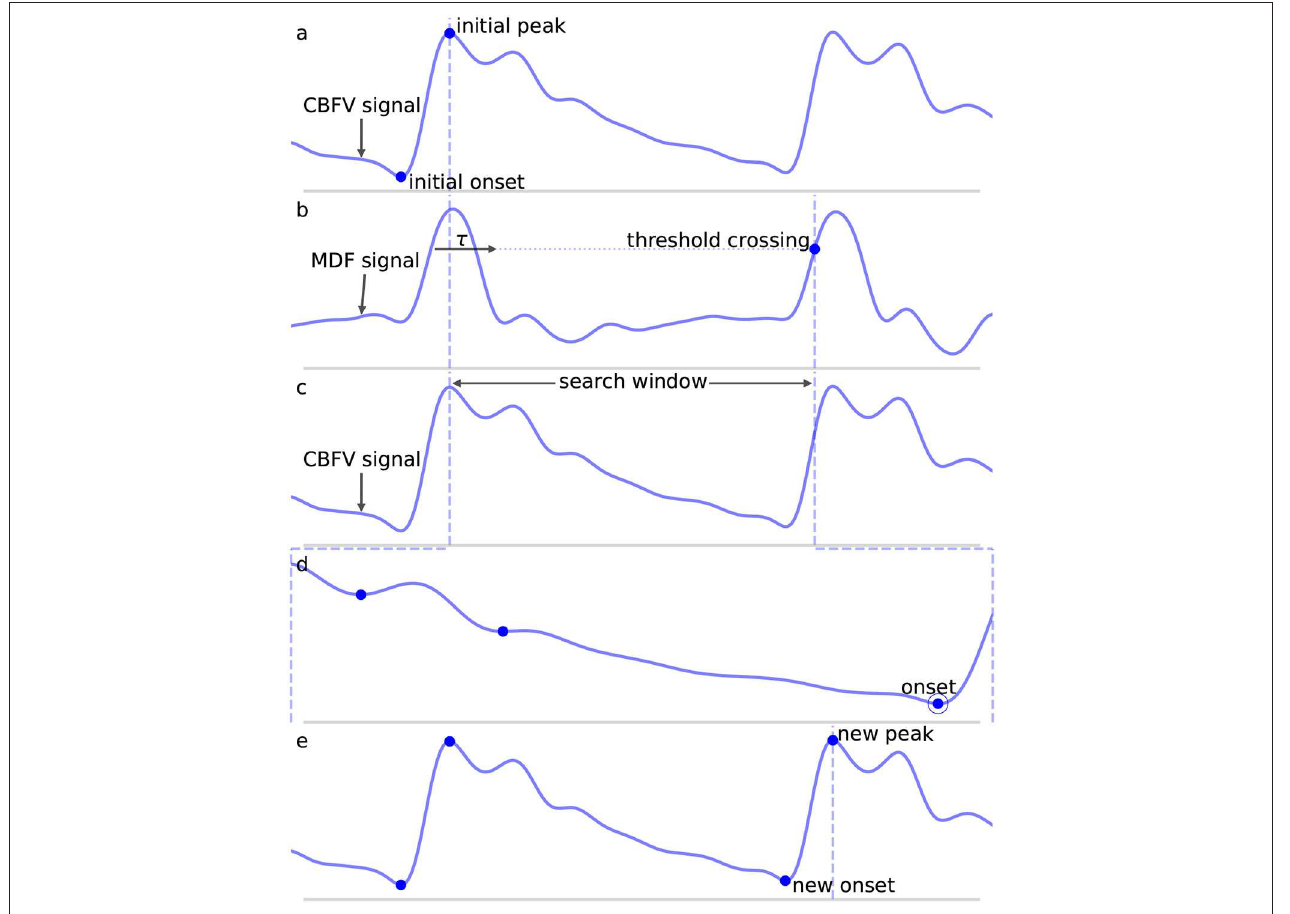
FIGURE 3 | Shown are the major steps in the algorithm, from an initial seed onset to detection of the next onset. The x (time) and y (CBFV/MDF amplitude) axes have been normalized to dimensionless quantities for ease of viewing. The algorithm proceeds from onset to onset in this manner until the end of the scan is reached. (a) Shows the initial onset in the CBFV signal, which consists of the onset point itself and its associated peak. (b) Displays the MDF signal associated with this same segment of data and shows how the search window is established after enforcing the refractory period and locating the threshold crossing point. (c) Shows the CBFV signal with the search window overlaid. (d) Shows a zoom-in of the search window and the location of all valleys, with the new onset labeled. Finally, (e) shows the original CBFV signal with the new onset